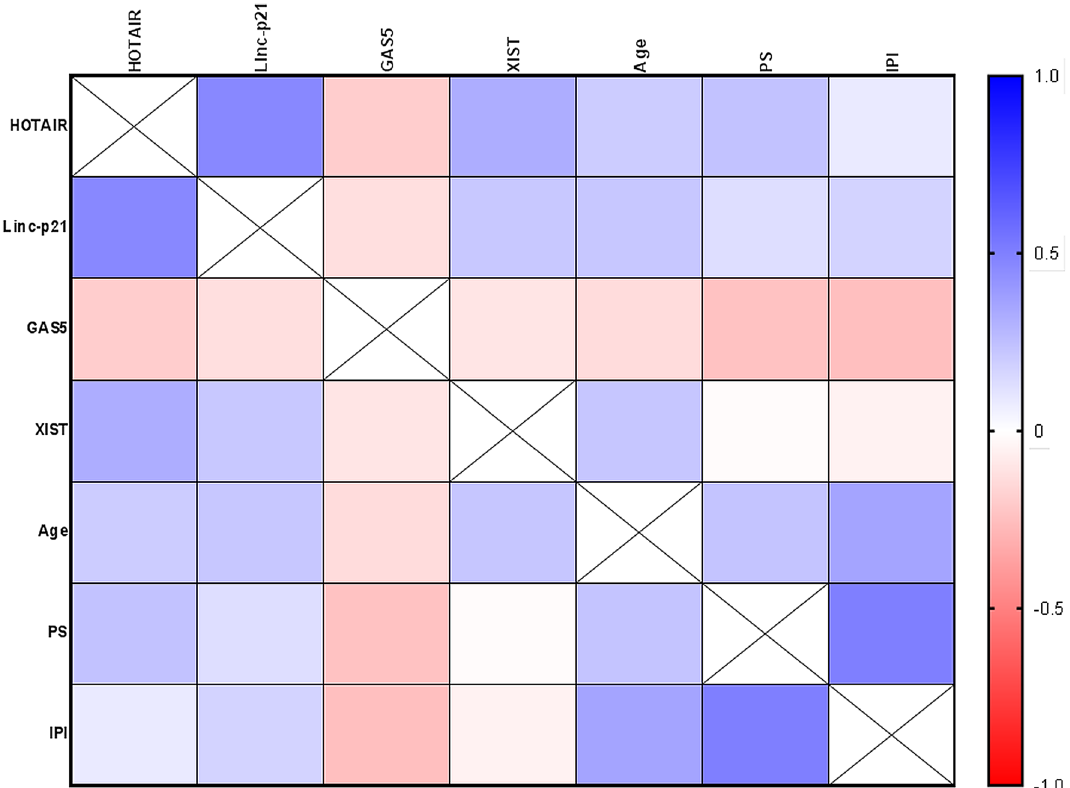
Figure 5. Correlation between plasma lncRNAs levels with each other and with clinical data. A correlation map with a blue-red scale. The blue color corresponds to a correlation close to 1 and the red color corresponds to a correlation close to − 1. Correlations are made by Spearman correlation. IPI International Prognostic Index, PS performance status.